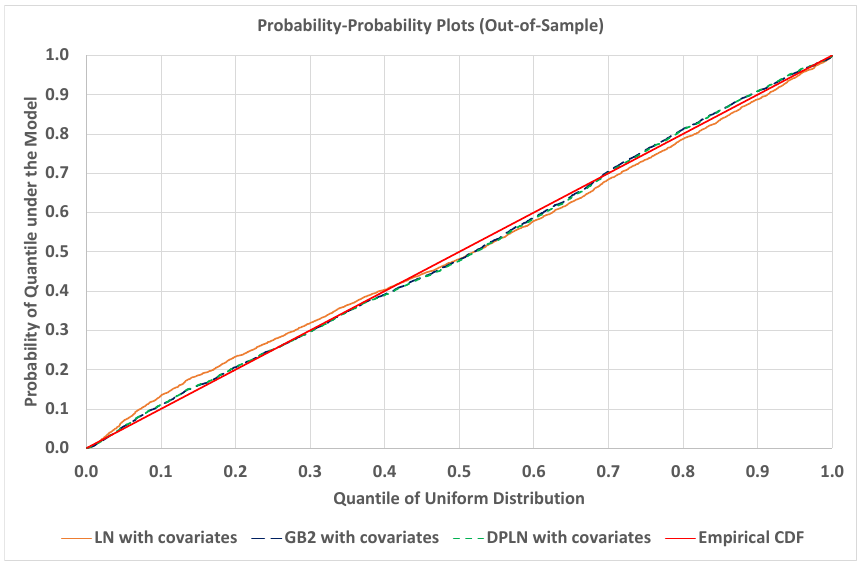
Figure 3. Probability-probability plot (out-of-sample).